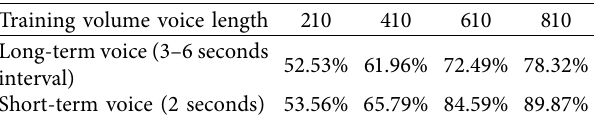
Table 4: Recognition rate of 190 strange recognition corpora in different